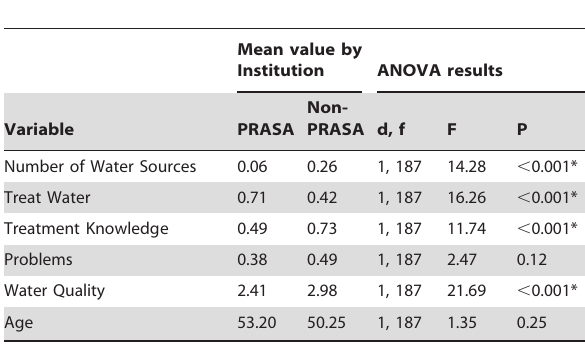
Table 2. Comparison of each variable considered in our statistical models by institution type (PRASA vs non-PRASA).